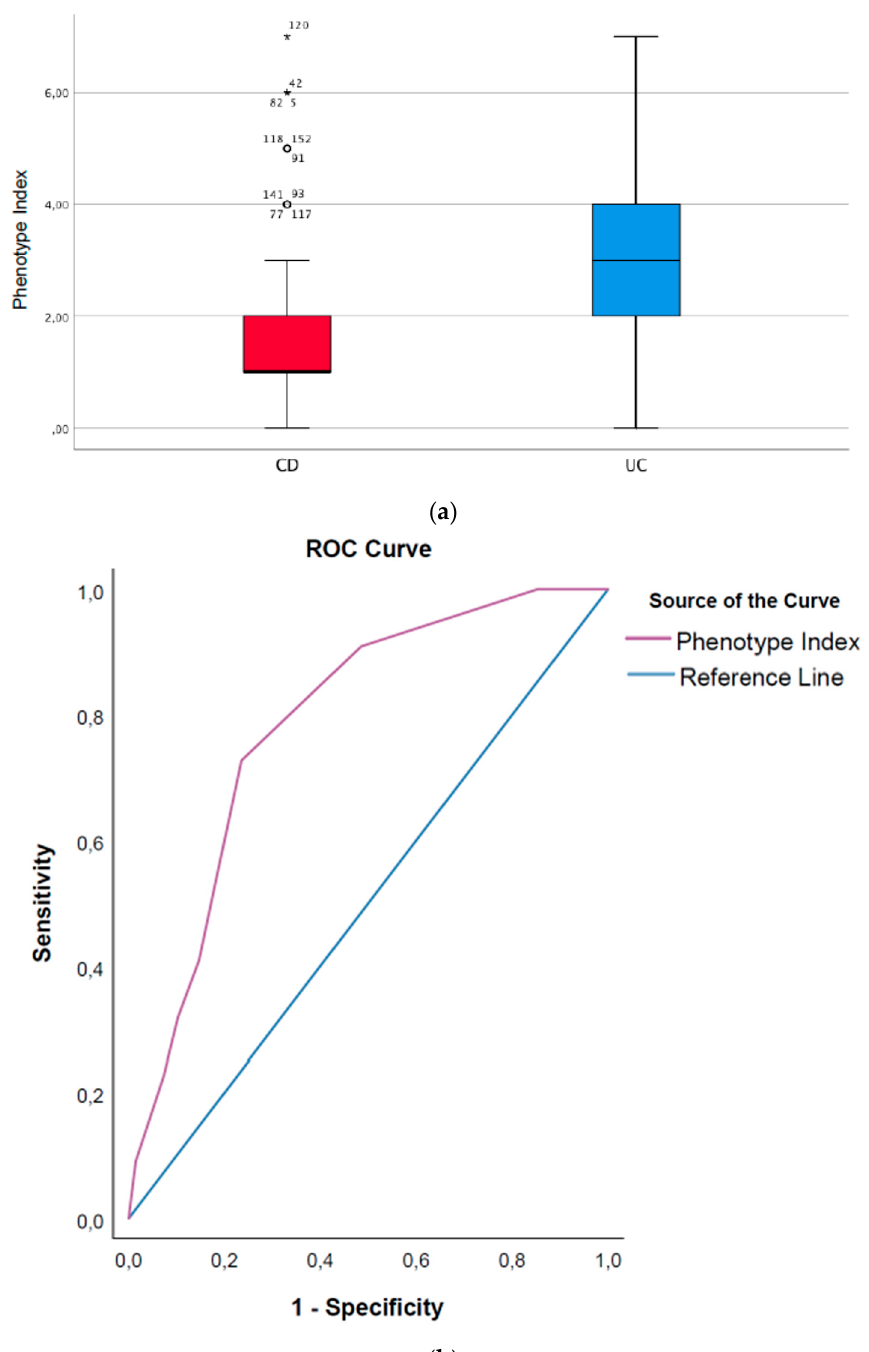
Figure 4. ( a ) Boxplot illustrating the Phenotype Index differentiating between CD and UC; ( b ) Roc curve showing the AUC of the Phenotype Index differentiating between CD and UC. Prognostic Index (Need for Biologic Therapy vs. No Need) A higher Prognostic Index (PI) score indicated a need for biologic therapy. For each unit increase of this index, there was a twofold increase in the odds for biologic treatment (OR = 2.1, 95%CI [1.40 to 3.46], p = 0.001). The PI had good discrimination properties, with an AUC of 0.72, 95%CI [0.63 to 0.82] (Figure 5a,b). The AUPRC for the PI is available as Supplementary Figure